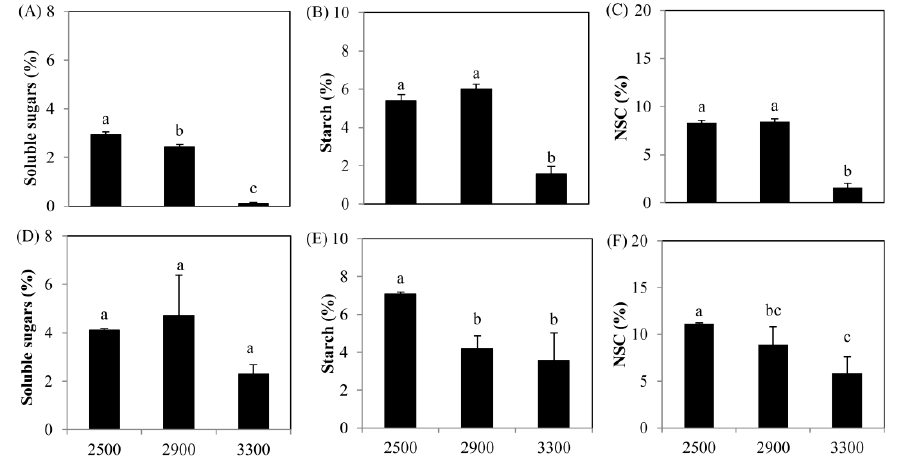
Figure 2. Changes of non-structural carbohydrates in the roots of Picea crassifolia with the increasing elevations (m). ( A – C ), coarse roots with 0.5–1.0 cm in diameter; ( D – F ), fine roots with <0.5 cm in diameter. Different lowercase letters represented the significance levels ( p < 0.05) among the different elevations.